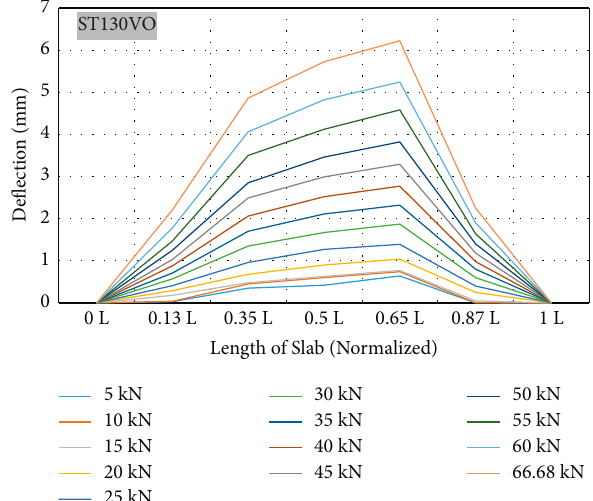
Figure 10: Deflection profile of slab